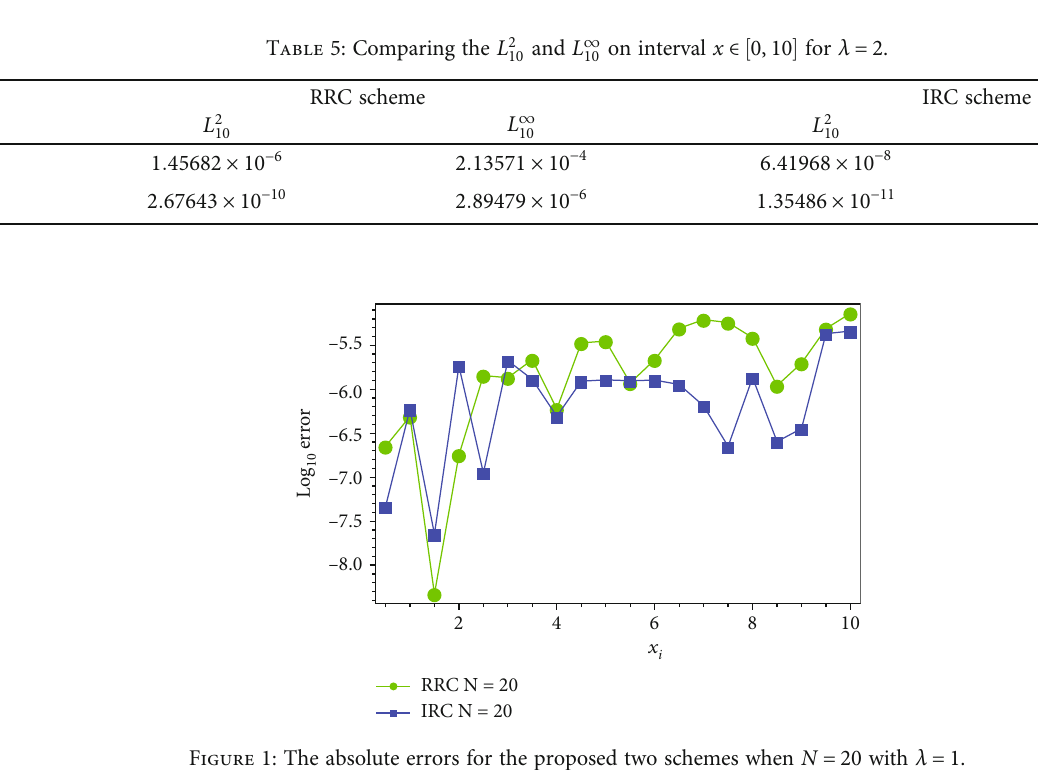
Table 4: Comparing the L 2